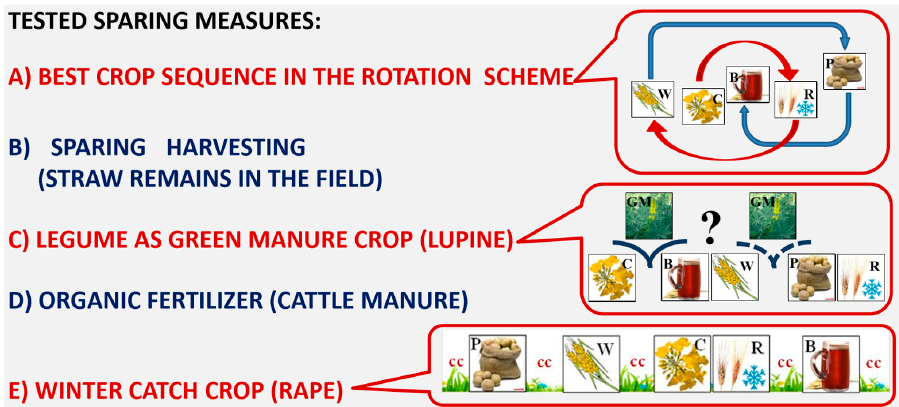
Figure 7. The tested sparing measures.